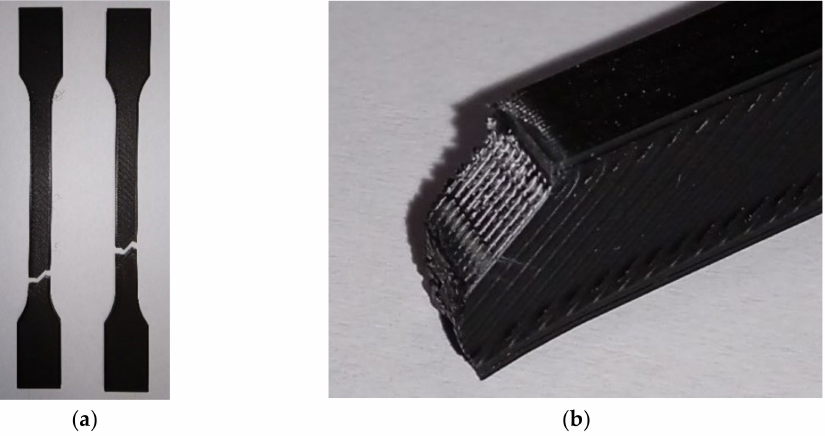
Figure 4. Breaking surface aligned with the raster angle; ( a ) ISO 527-2:2012 1A specimens; ( b ) detail. Inter-line failure can be associated with reduced diffusion between the raster lines. The occurrence of inter-line failure at the XY specimens with a unidirectional raster angle of θ = 90 ◦ is the cause for the lower tensile strength of these specimens relative to the tensile strength of specimens with θ = 0 ◦ or θ = 45 ◦